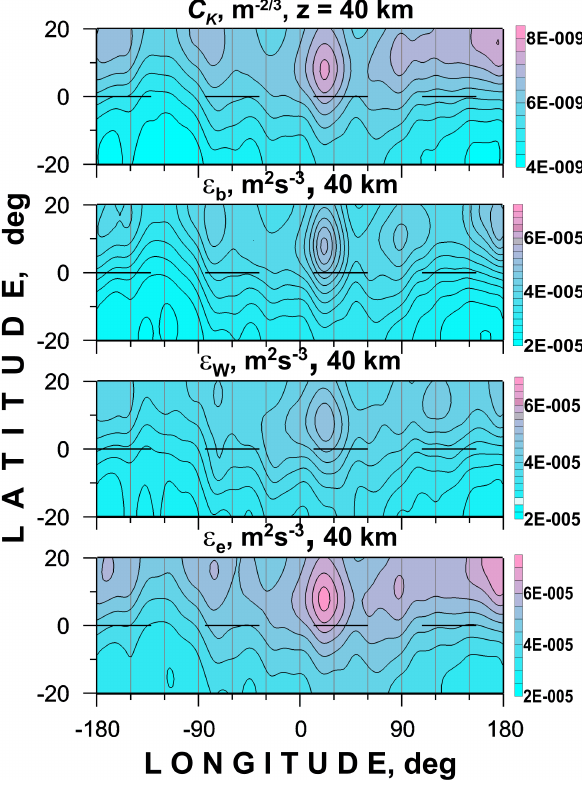
Fig. 3. Latitude-longitude distributions of different estimates of tur- bulent energy dissipation rates in September–November 2004 at 40km